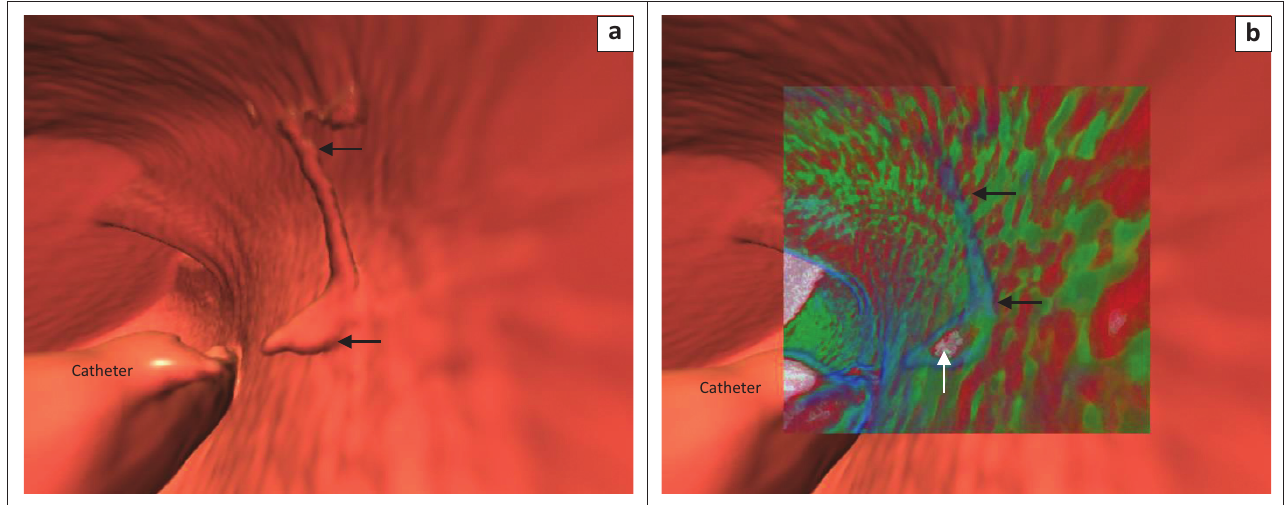
FIGURE 10: (a) 3D view shows curvilinear density indicating an artefact (black arrows); (b) TD shows thin blue line (black arrows) with a small blob of barium (white arrow) inferiorly indicating barium and air